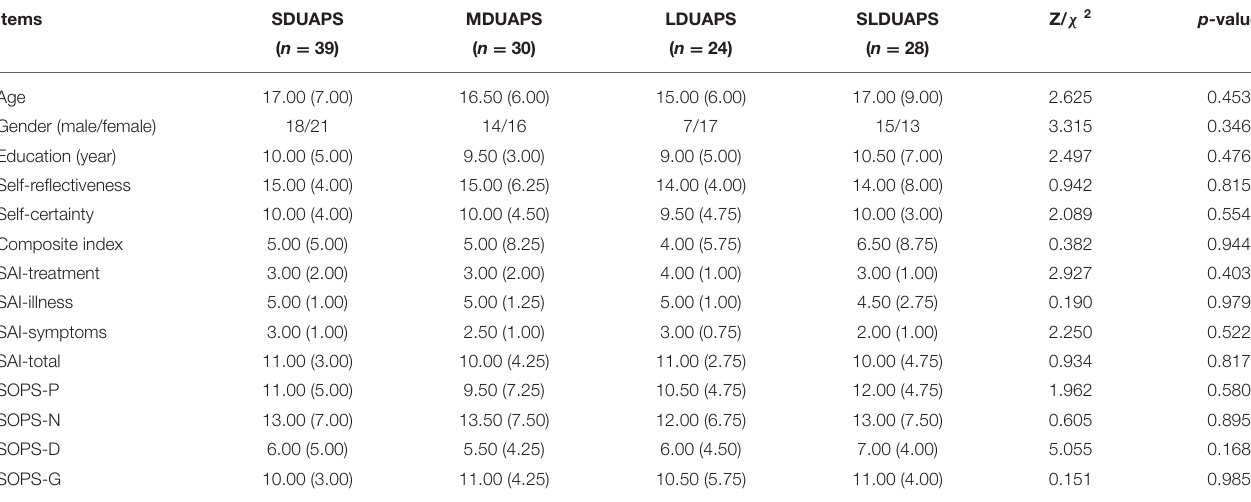
TABLE 2 | Demographic, cognitive and clinical insight, and other clinical variables of APS subgroups with different DUAPS.